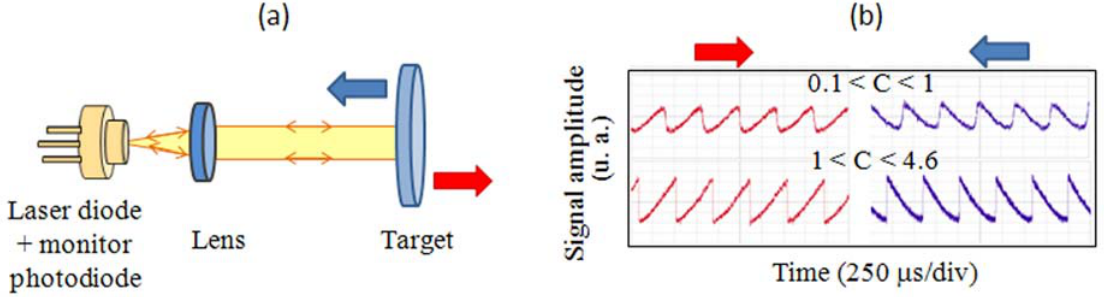
Figure 2. (a) Schematics of the LSM interferometer, with the target moving forward (red arrow) or backward (blue arrow) with respect to the laser source. (b) Experimental oscilloscope waveforms obtained for different values of the feedback parameter C in presence of a linear continuous displacement of the target at a speed of 1 mm/s in backward (blue traces) and forward (red traces) direction with respect to the laser